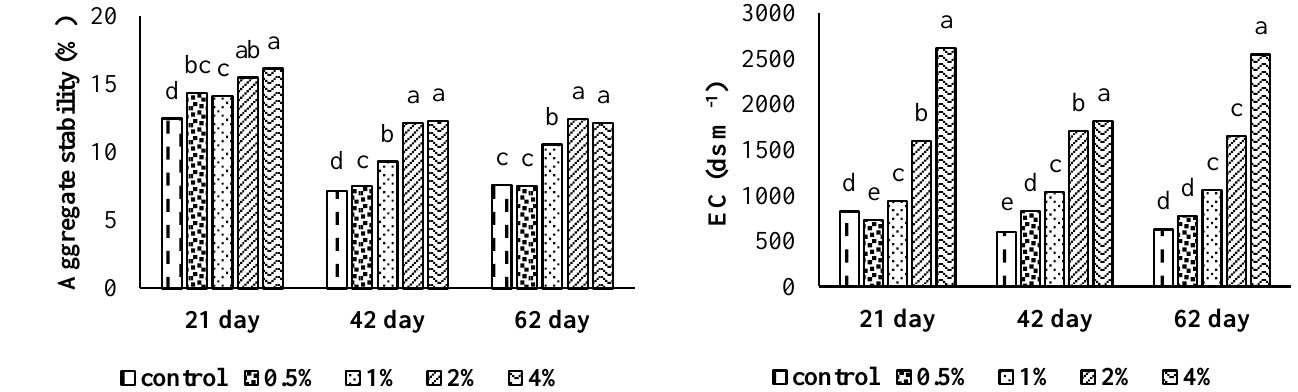
Figure 2. Effects of different rates of HA applications on aggregate stability.